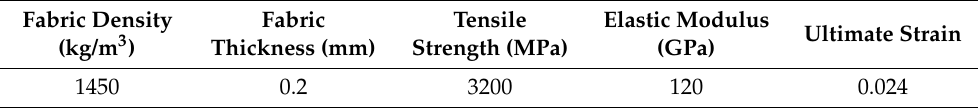
Table 1. Mechanical properties of